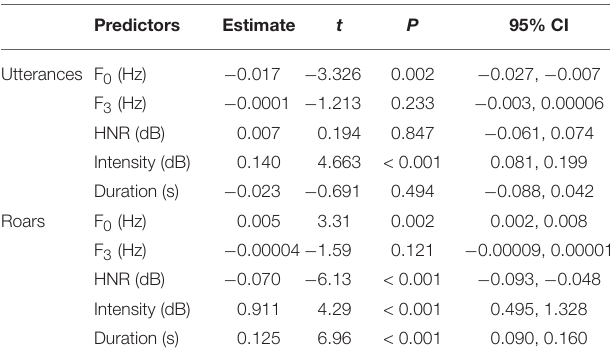
TABLE 4 | Summary of linear mixed effects model analysis for acoustic predictors of perceived formidability based on utterances and roars. Predictors